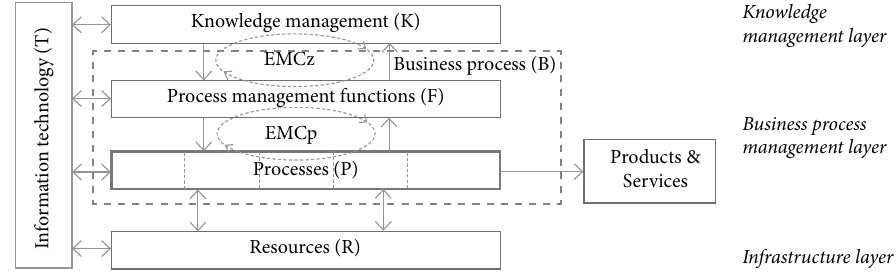
Fig. 3. The Knowledge-based Enterprise represented as modified VCM, including knowledge management layer (Gudas, Brundzaite